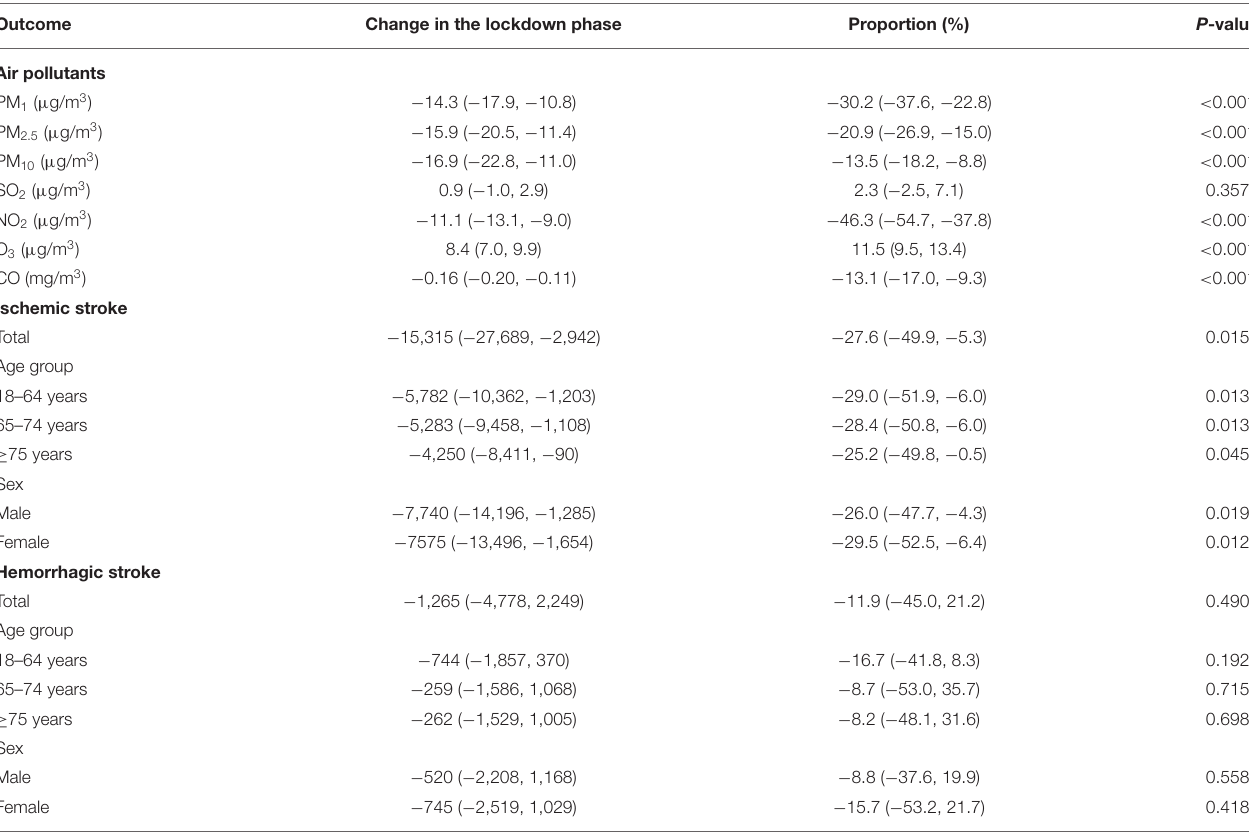
TABLE 2 | Changes in average air pollutant concentration levels and total counts of stroke cases in the lockdown phase relative to the counterfactual lockdown phase of the past 2 years.